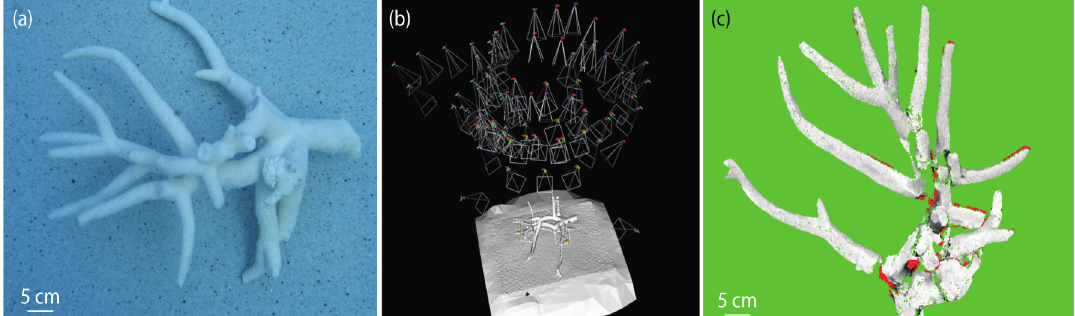
Figure 2. ( a ) Sample image collected for use in the reconstruction of the branching coral; ( b ) camera positions used to compute the 3D reconstruction of the coral; and ( c ) gathered error statistics for the coral with variance σ = 0.1 mm. Green denotes no ground-truth measure due to occlusion, red a gross error (>10 σ ), white no error increasing towards black (10 σ ).